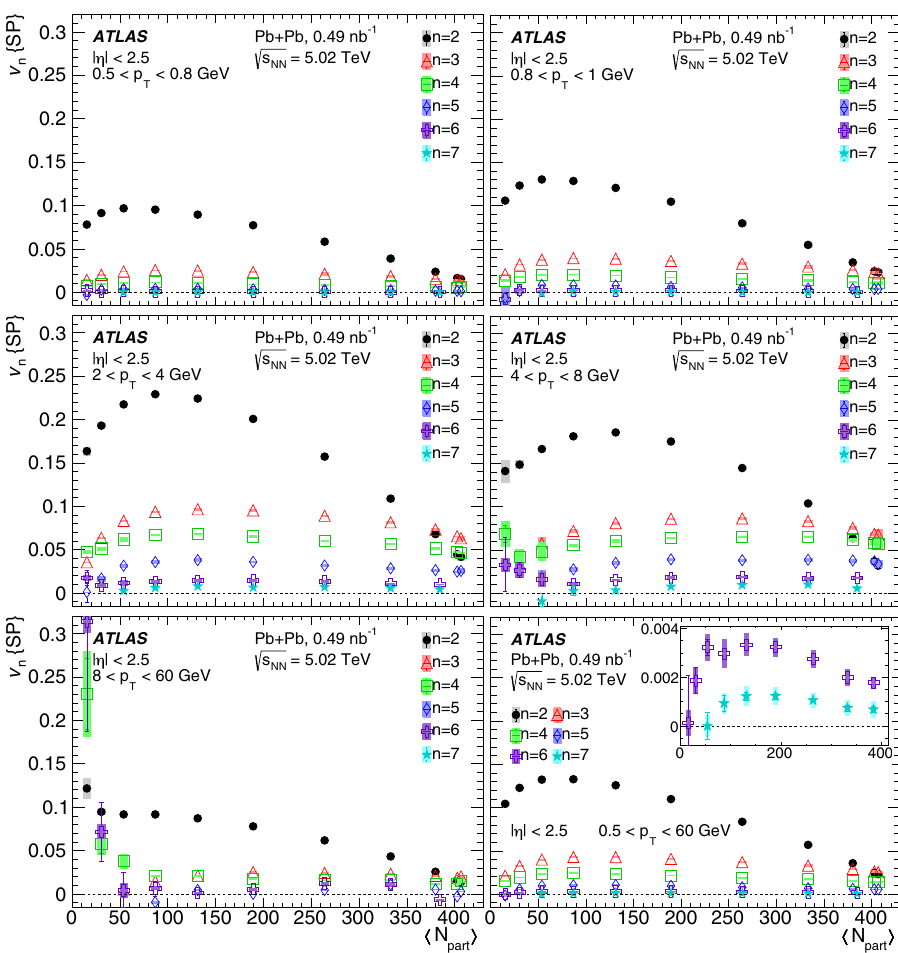
Fig. 12 Integrated v n { SP } vs. N part for six p T ranges shown in the panels from lowest p T range at the top left to the highest at the bottom middle, measured using the scalar-product method. In the inset in the bottom-right panel the v 6 and v 7 integrated over 0 . 5 < p T < 60 GeV are shown with adjusted scale. The correspondence of N part to centrality intervals is provided in Table 2. Results are averaged over the intervals indicated by horizontal error bars. The vertical error bars indicate statistical uncertainties. The shaded areas indicate systematic